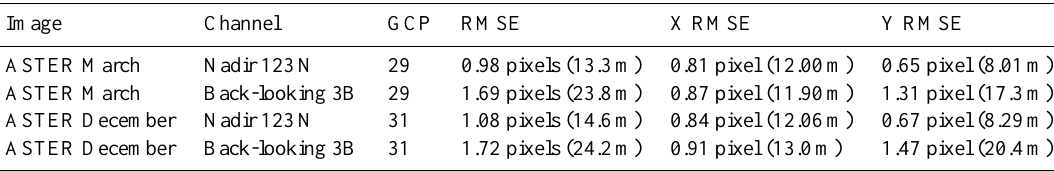
Table 2. Generation of DEM from two ASTER images. The table summaries the root mean square error (RMSE) for the ground control points (GCPs) for 123N and 3B image